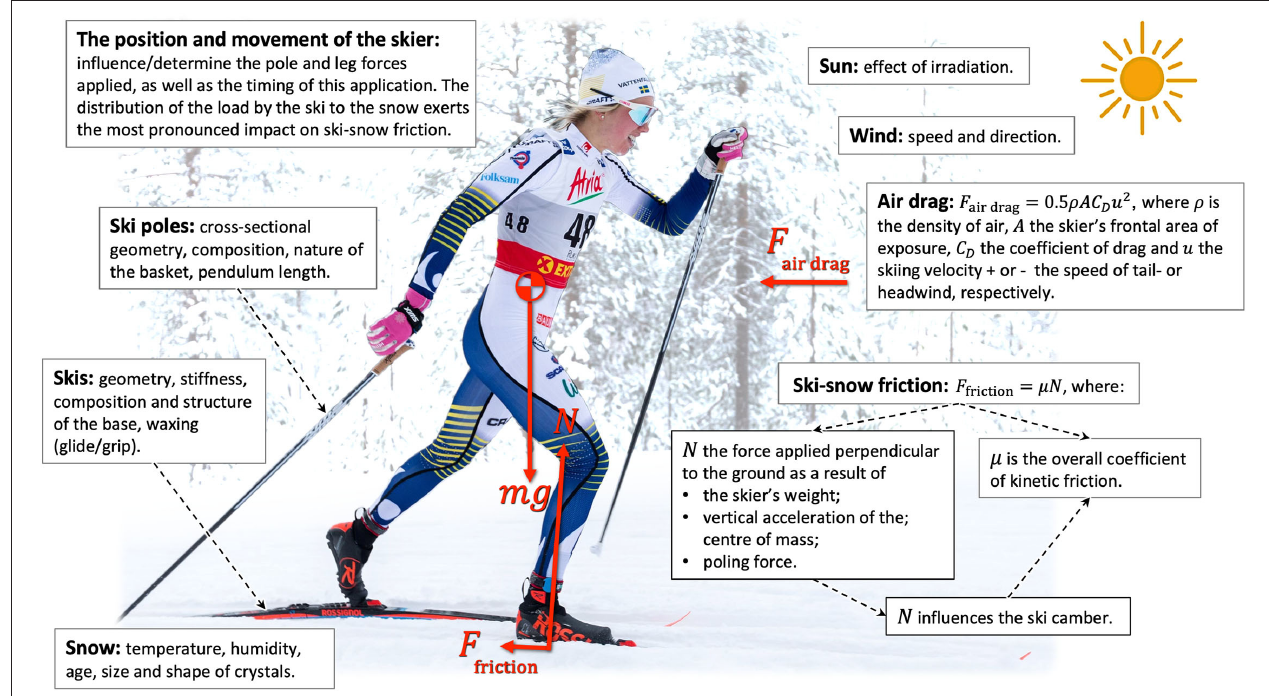
FIGURE 1 | Illustration of the resistive forces acting on a cross-country skier and factors that influence these forces.